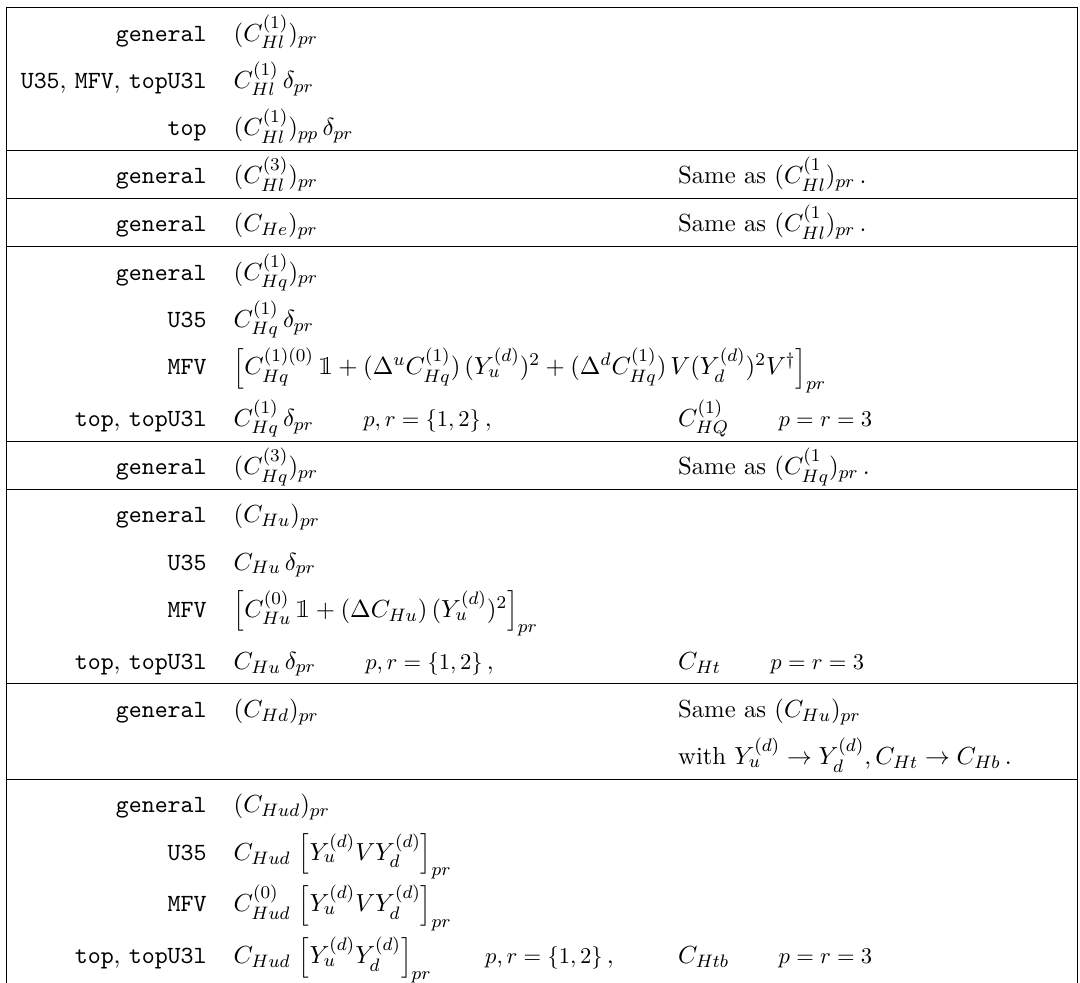
Table 11 . Conversion table among the 5 flavor assumptions considered, for the operators in L (7)